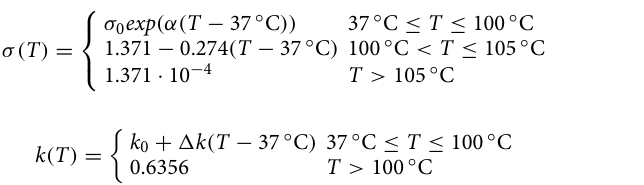
Table 4. Electrical properties were different for both techniques according to the frequency of the applied electric field in each case. The sensor was included only in the RFA models. Radiofrequency ablation